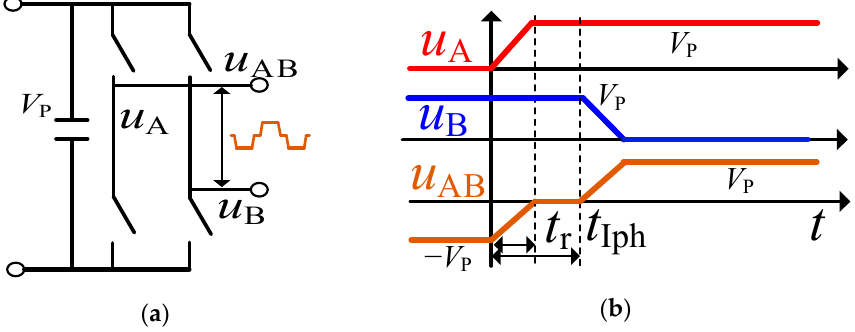
Figure 8. Output voltage of the active bridge. ( a ) H bridge; ( b ) output voltage.